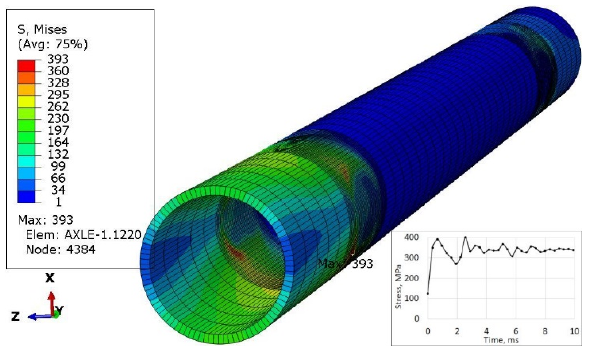
Figure 9. Stress distribution in the axle while only both wheels break.